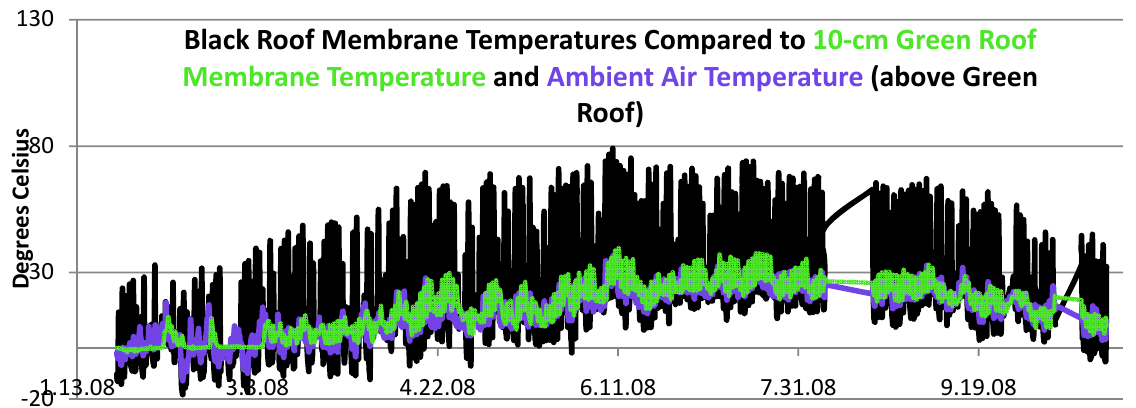
Figure 7. Comparative surface membrane temperatures on a black roof compared to the 10-cm sedum green roof of figure 1a. Also shown in blue are the ambient air temperatures monitored above the green roof. The dramatic reduction in temperatures on green roofs is evident. The green membrane temperatures are close to ambient air temperatures. Black Roof Membrane Temperatures Compared to 10 ‐ cm Green Roof Membrane Temperature and Ambient Air Temperature (above Green